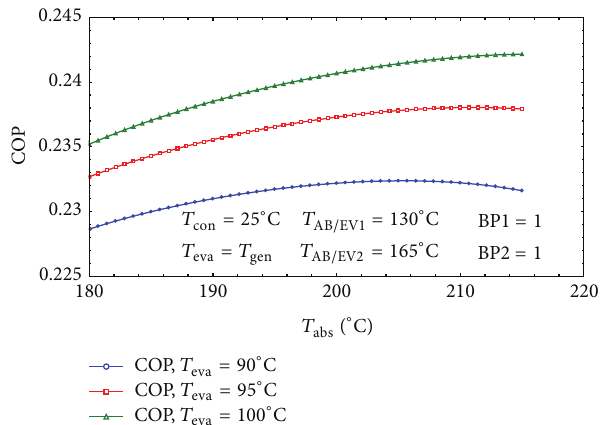
Figure9:Theeffectof 𝑇 𝑇 eva